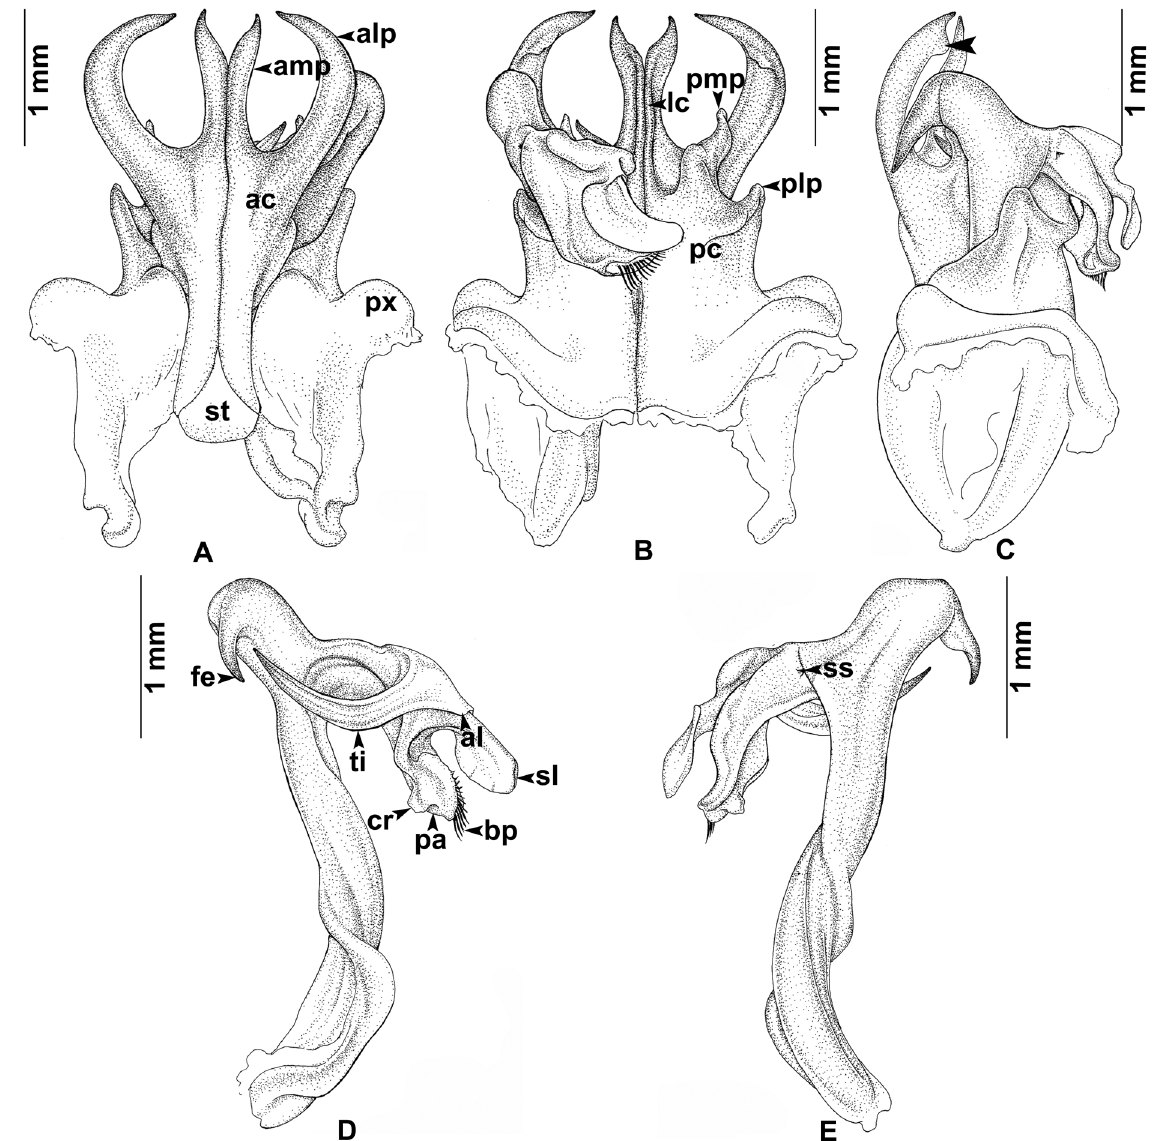
Fig. 5. Thyropygus mesocristatus sp. nov., from Srikasorn, holotype (CUMZ-D00094), ♂, gonopods. A . Anterior view, left telopodite removed. B . Posterior view, left telopodite removed. C . Lateral view. D . Left telopodite, posterior-mesal view. E . Left telopodite, anterior-lateral